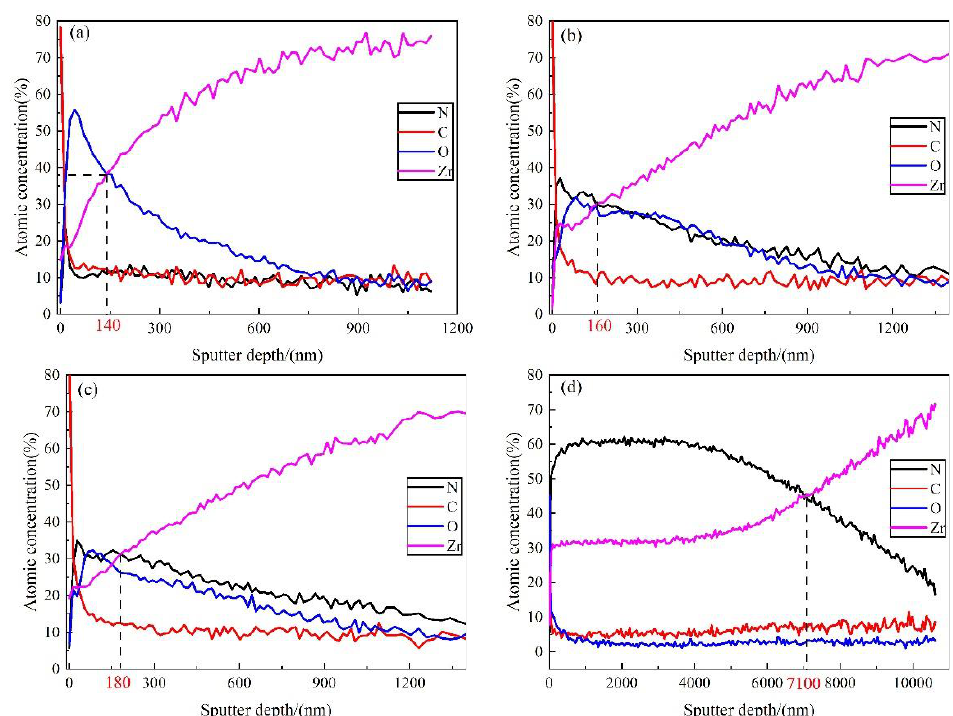
Figure 6. AES element distribution with sputtering depth in the film prepared in N 2 + H 2 at 500~800 °C for 20 h ( a ) 500 °C; ( b ) 600 °C; ( c ) 700 °C; ( d ) 800 °C . The Zr content in the film formed at 800 °C increased with the increase of the sput- tering depth, while the N content increased firstly and then decreased with the highest value of about 60% at a depth of 1000 nm. The content of O decreased to almost zero when